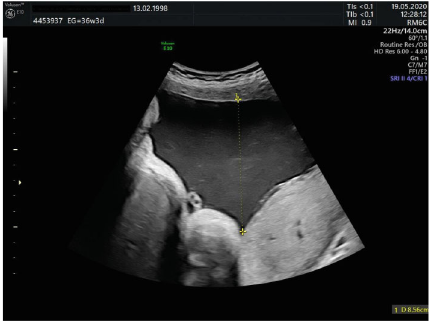
Figure 2: Polyhydramnios (maximum vertical pocket 86 mm at 36 3/7 weeks of